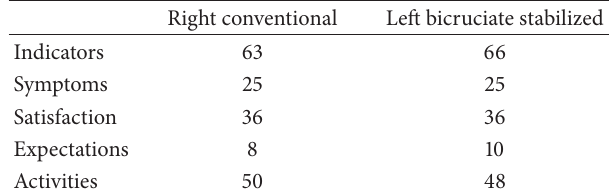
Table 1: New knee society